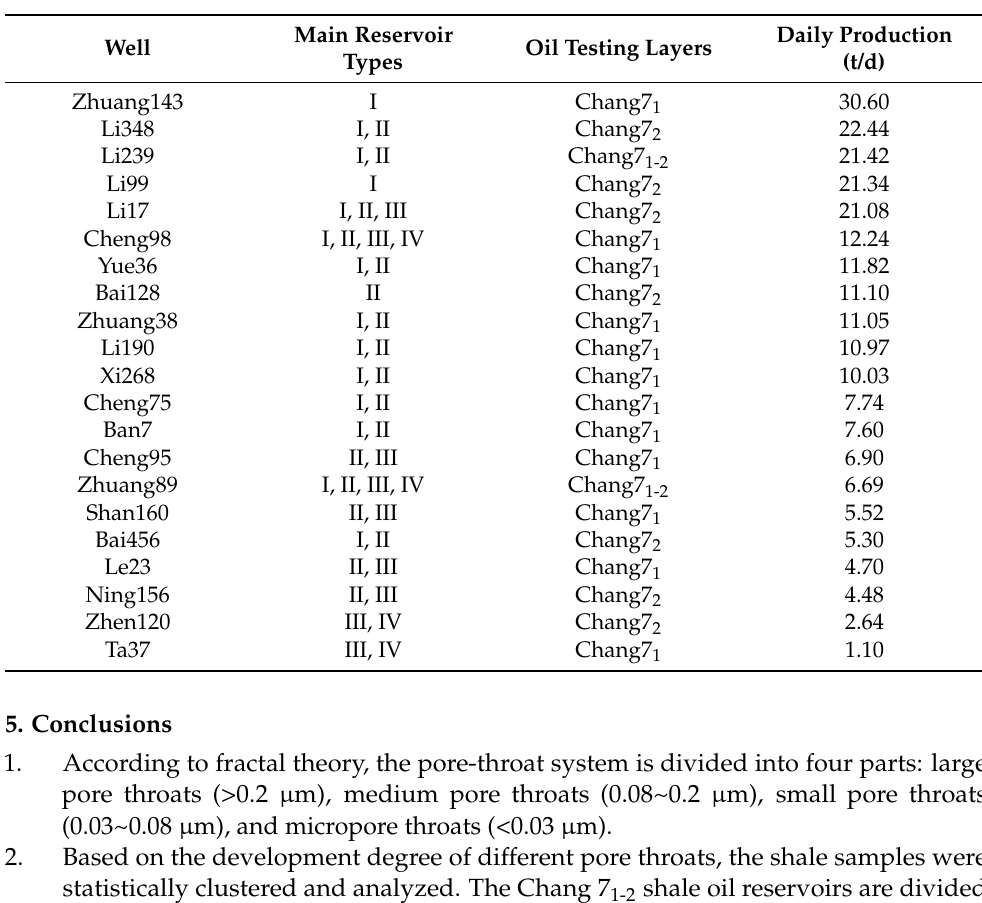
Table 2. Different types of reservoirs with single well daily